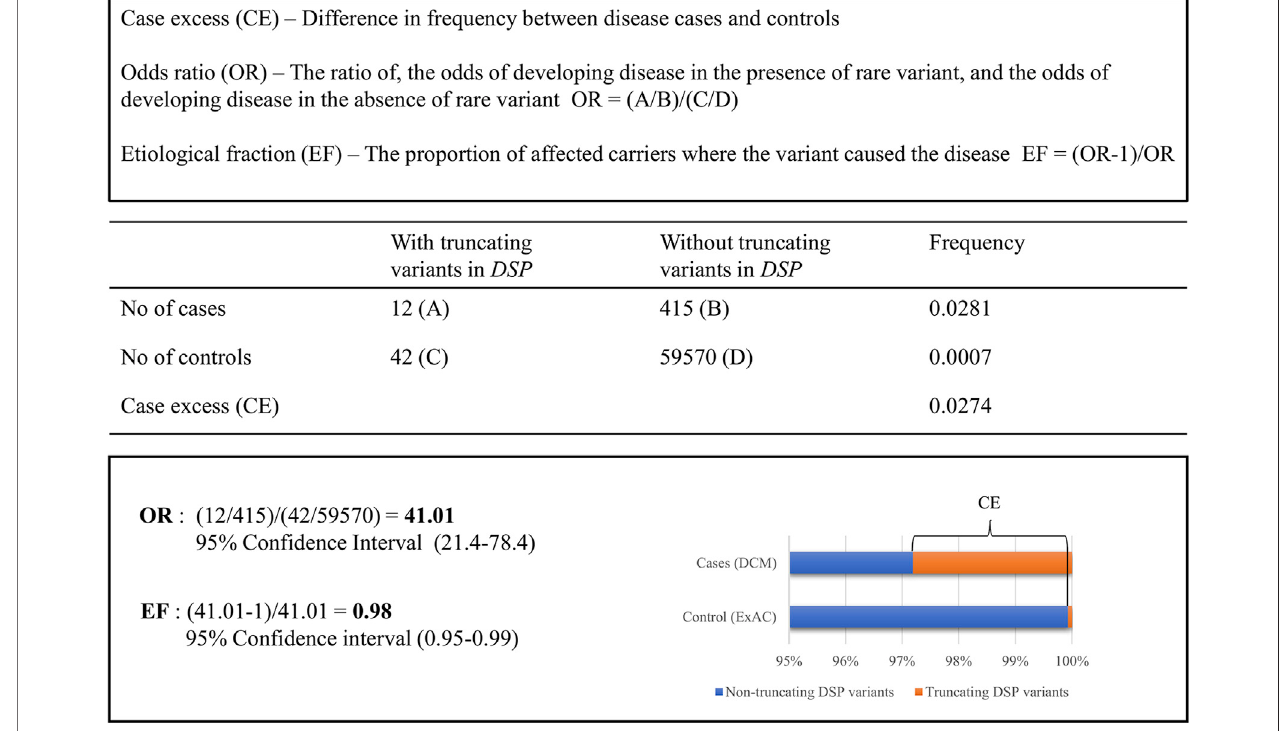
FIGURE 1 | Comparing the frequency of rare truncating variants (ExAC MAF < 0.0001) in the DSP gene for clinical DCM cases compared to ExAC